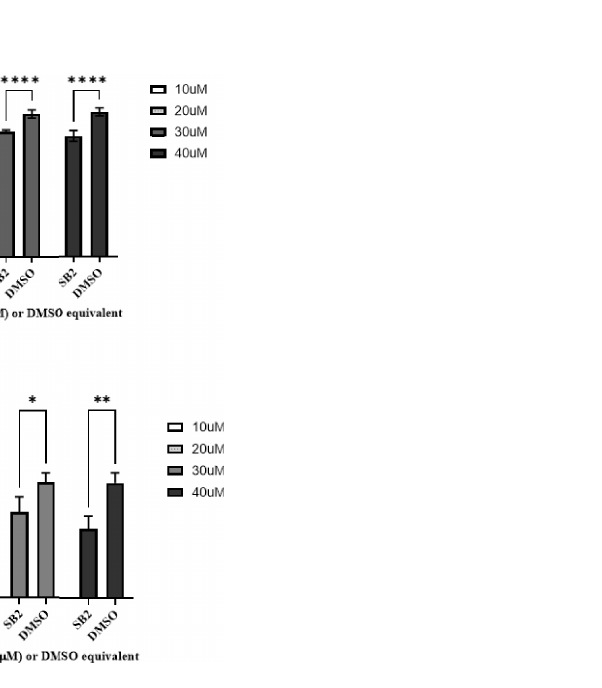
FIGURE 2 | Phospho-p38 MAPK inhibitor decreases JUNV pseudovirus and wild type virus replication in vitro in a dose – response. HSAEC cells were pretreated with SB 203580 in a dose curve for 2 h in triplicate wells, and then infected with JUNV Romero pseudovirus (A) which contains a GFP signal or JUNV CD1 (B) . (A) The pseudovirus GFP signal was measured by high-content imaging 48-hours post infection. (B) For the JUNV CD1 samples, 24-hours post infection the cells were fi xed and the JUNV nucleocapsid protein was stained with a mouse monoclonal anti-N antibody and detected with an Alexa fl uor-488 conjugated secondary, the nuclei was stained with Hoescht and the signal was measured by high content imaging. The data is plotted as means with standard deviations. P-values less than 0.05 were considered signi fi cant. One representative of two experiments is shown for both the pseudovirus and wild type virus. (A) **p=0.0018, ****p<0.0001, ns, not signi fi cant. (B) *p=0.0344,